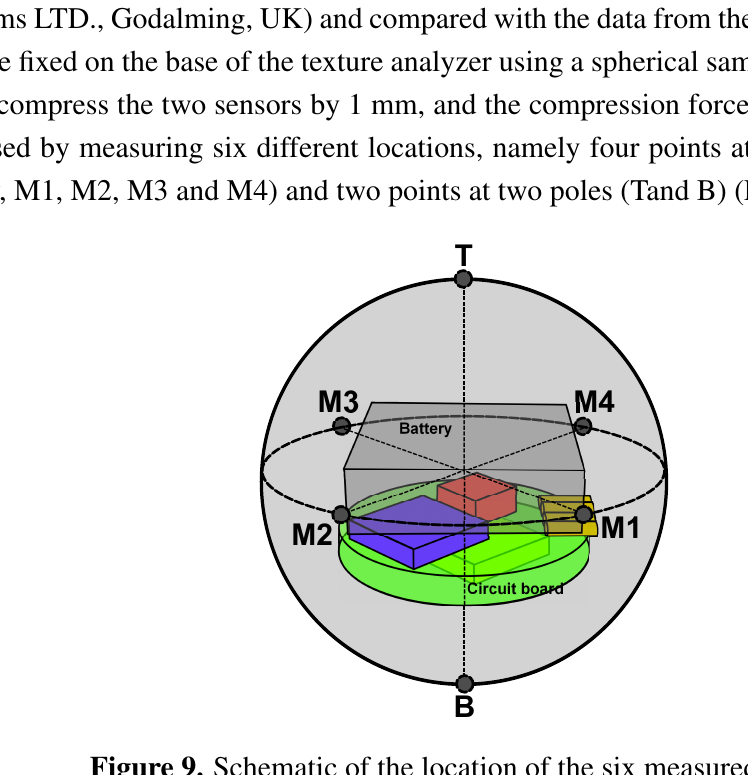
Figure 9. Schematic of the location of the six measured